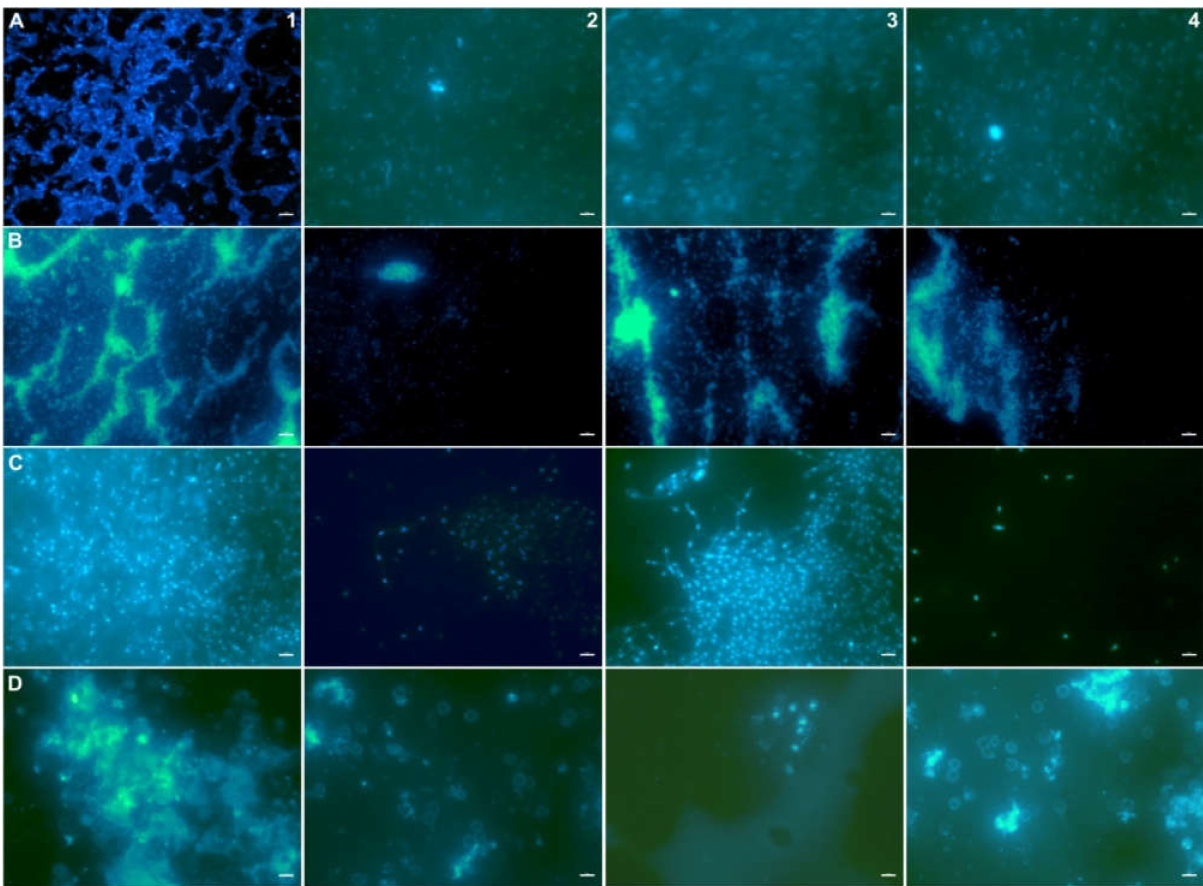
Figure 4. Microbial attachment observed by fluorescence microscopy: ( A ) A. hydrophila biofilms; ( B ) A. tumefaciens biofilms; ( C ) A. pullulans biofilms; ( D ) C. vulgaris biofilms; ( 1 ) control; ( 2 ) P-1; ( 3 ) P-2; ( 4 ) P-3 (scaling bar: 10 µ